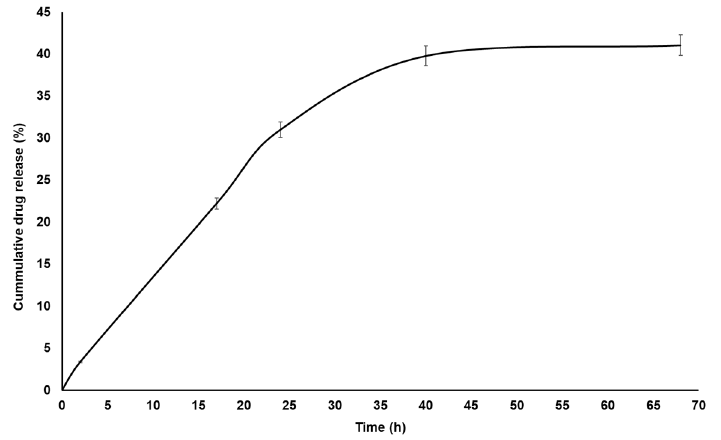
Figure 7. In vitro drug release profile of the diclofenac sodium loaded into CGP-PPG@diclofenac nanoparticles ( n = 6 determinations).